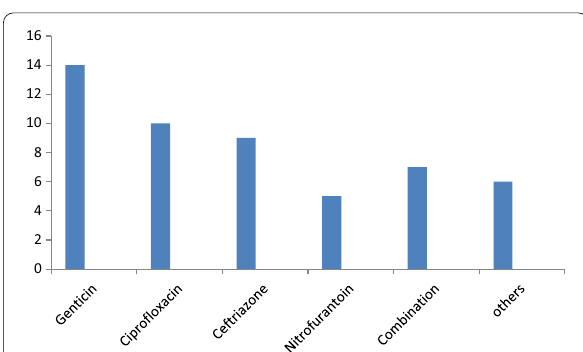
Fig. 1 Bar chart showing the commonly used prophylactic antibiotics by the